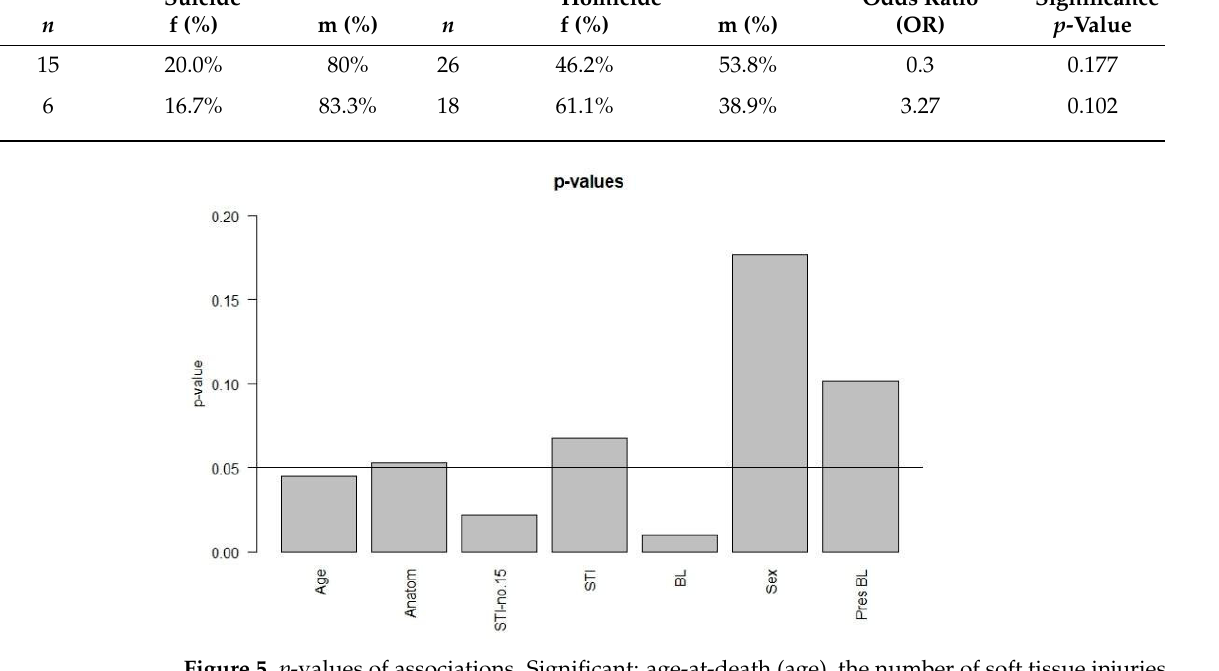
Figure 5. p -values of associations. Significant: age-at-death (age), the number of soft tissue injuries excluding case no. 15 (STI-no.15) and the number of bone lesions